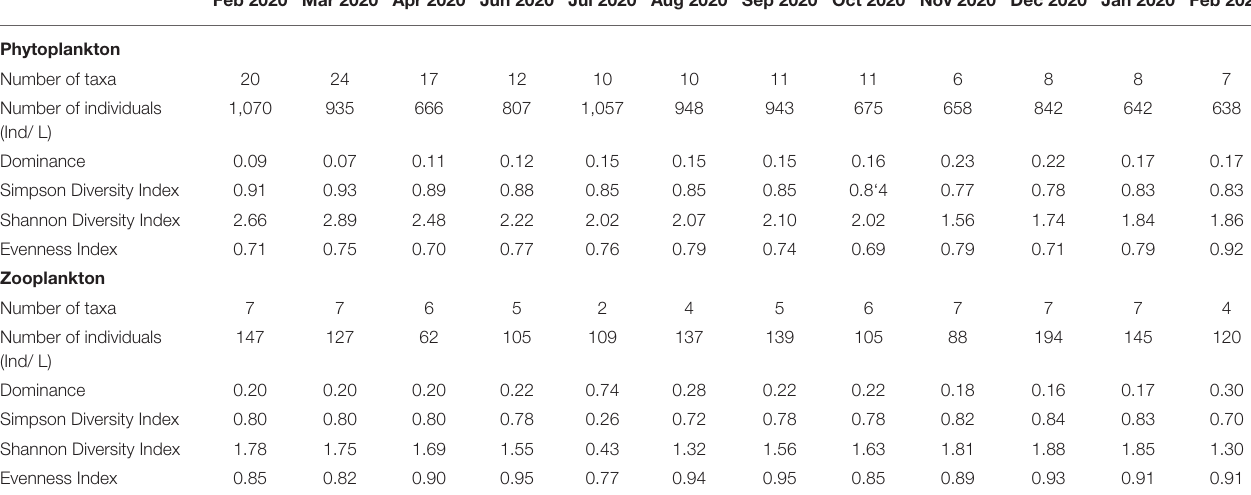
TABLE 2 | Temporal changes in diversity indices and number of taxa of phytoplankton and zooplankton in Lake Kanyaboli during the study period from February 2020 to February 2021.